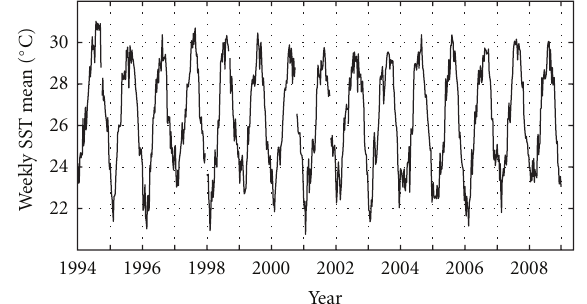
Figure 3: Time series of SST weekly means averaged for the 36 CREMP sites from 1994 to